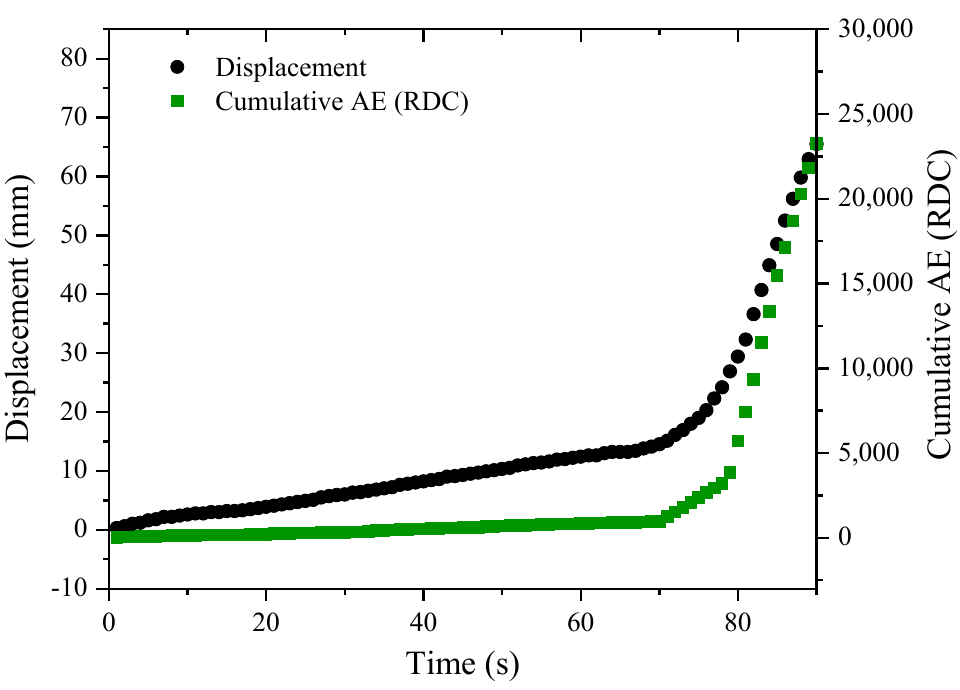
Figure 8. Sliding displacement and cumulative ring down count (RDC) plotted against time.